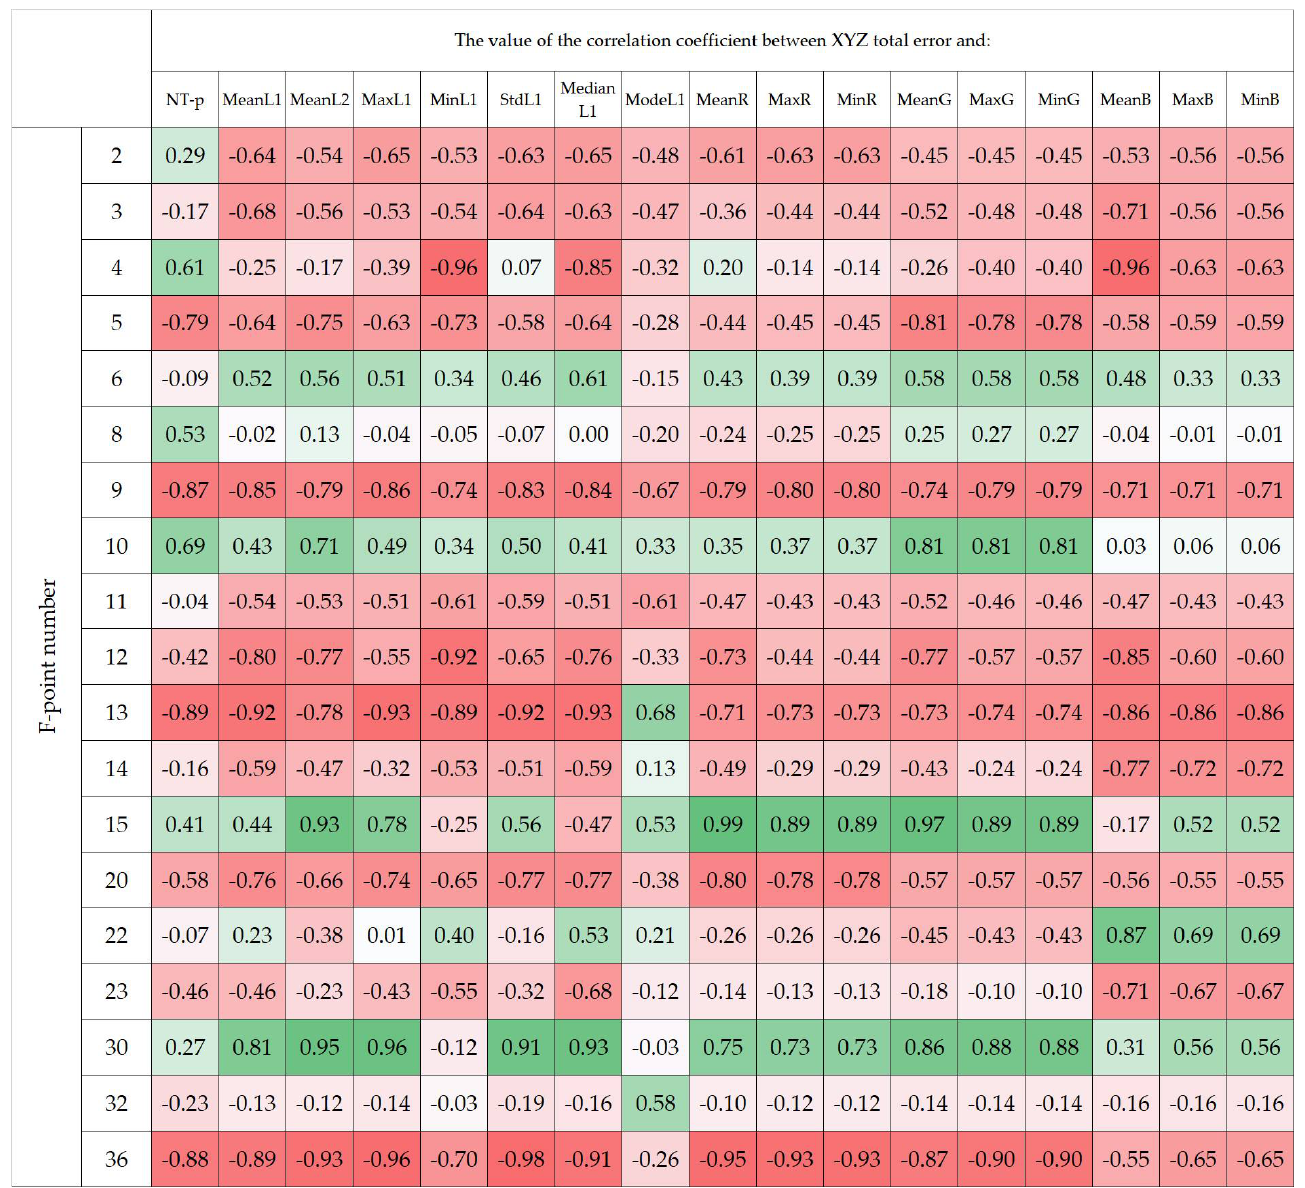
Figure 20. The value of the correlation coefficient between XYZ total error and the F-point features.